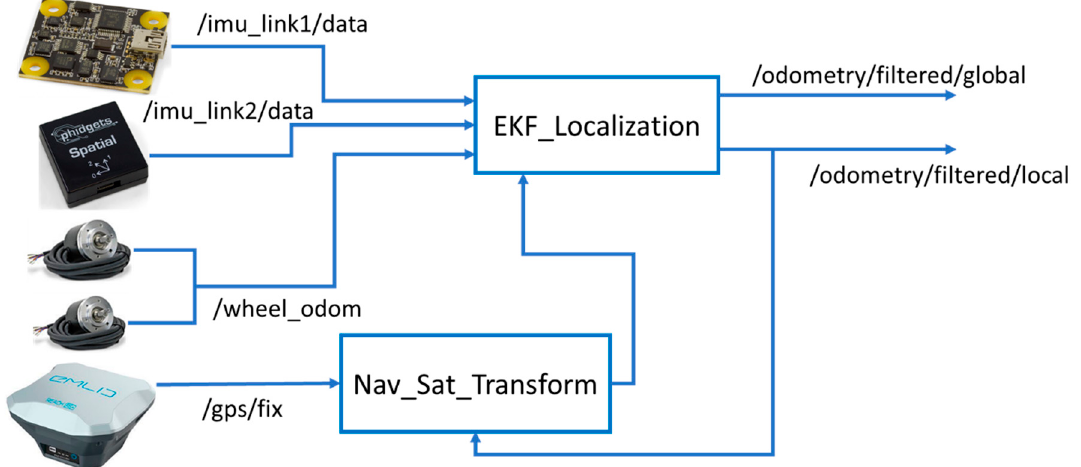
Figure 7. Simultaneous localization and navigation of the rover using dual Extended Kalman Filter (dual EKF).